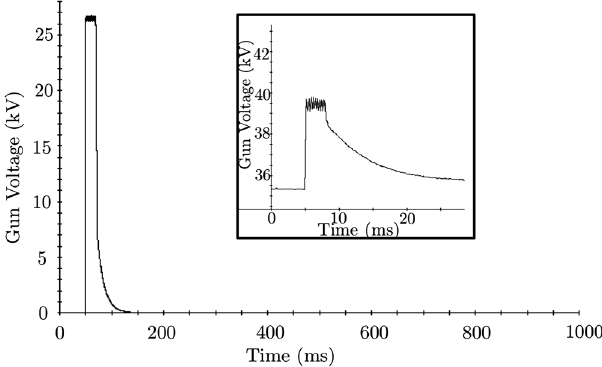
FIG. 2. Typical multipacting events at 26 kV and 40 kV of accelerating voltage during RHIC run 2016. rf pulse with 2 kW peak power was caught by multipacting barrier with typical zigzag (noisy) pattern in the read-back voltage, followed by an exponential decay after the rf pulse went off. Sampling rate of the data logging is 1 kHz, which could be insufficient to estimate the period of MP